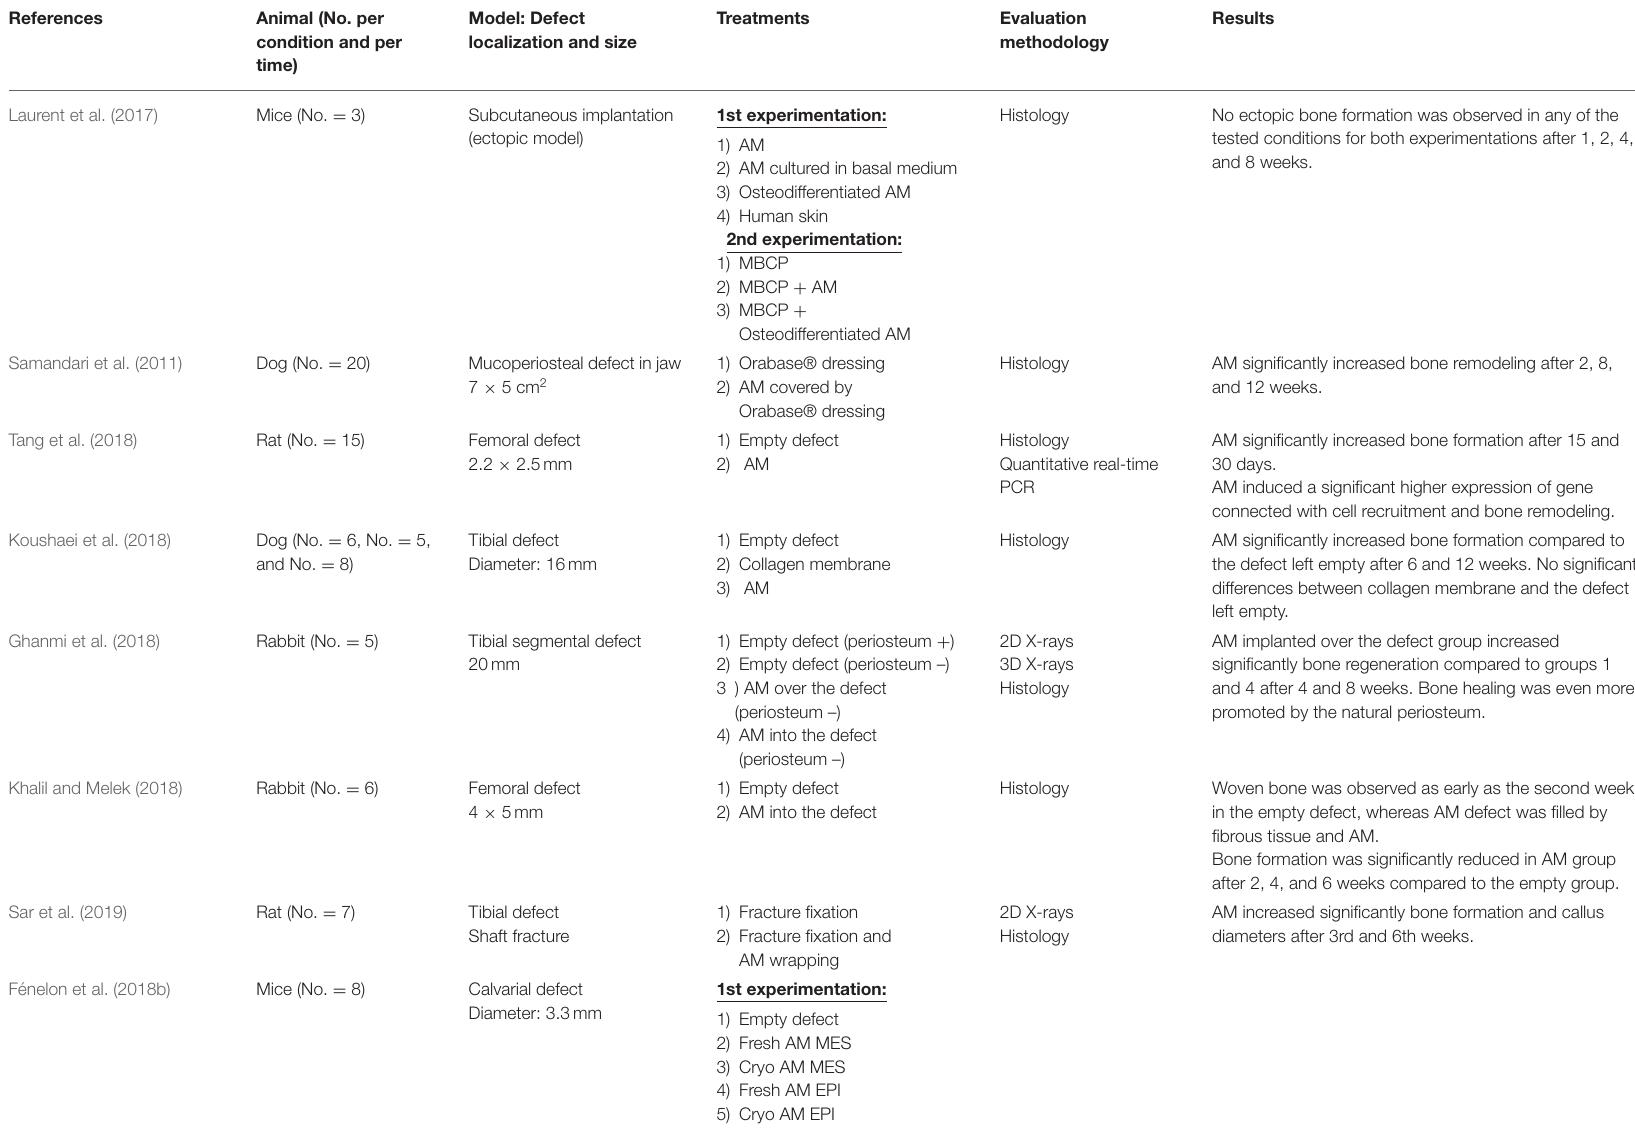
TABLE 2 | Pre-clinical studies using AM alone and/or combined with a bone substitute for bone